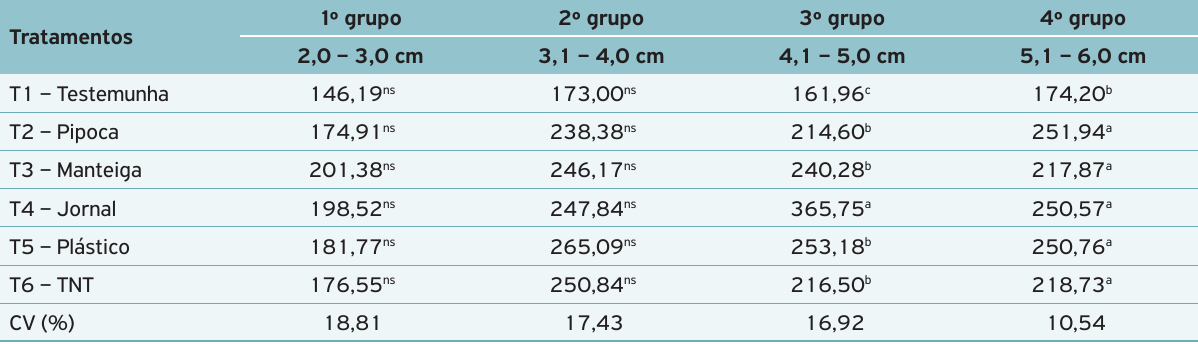
Tabela 4. Peso médio de frutos obtidos em quatro grupos de diâmetros de goiabas ensacadas com diferentes sacos em um pomar comercial no Crato, Ceará, entre 13 de outubro de 2011 e 16 de abril de